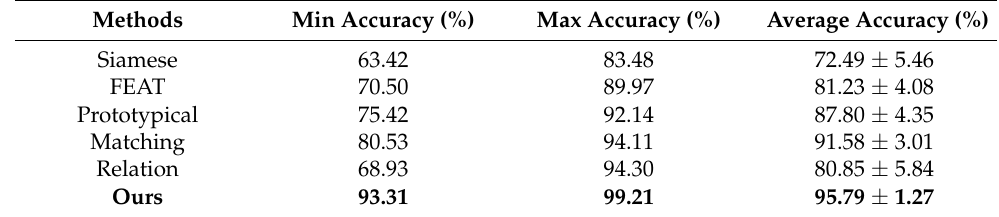
Figure 8. The visualization results of different methods on the MSTAR dataset under the “4-way 5-shot” condition, where ( a – e ) denote the different comparison methods and ( f ) denotes our proposed method. Table 5. “4-way 5-shot” recognition performance of different methods on the MSTAR